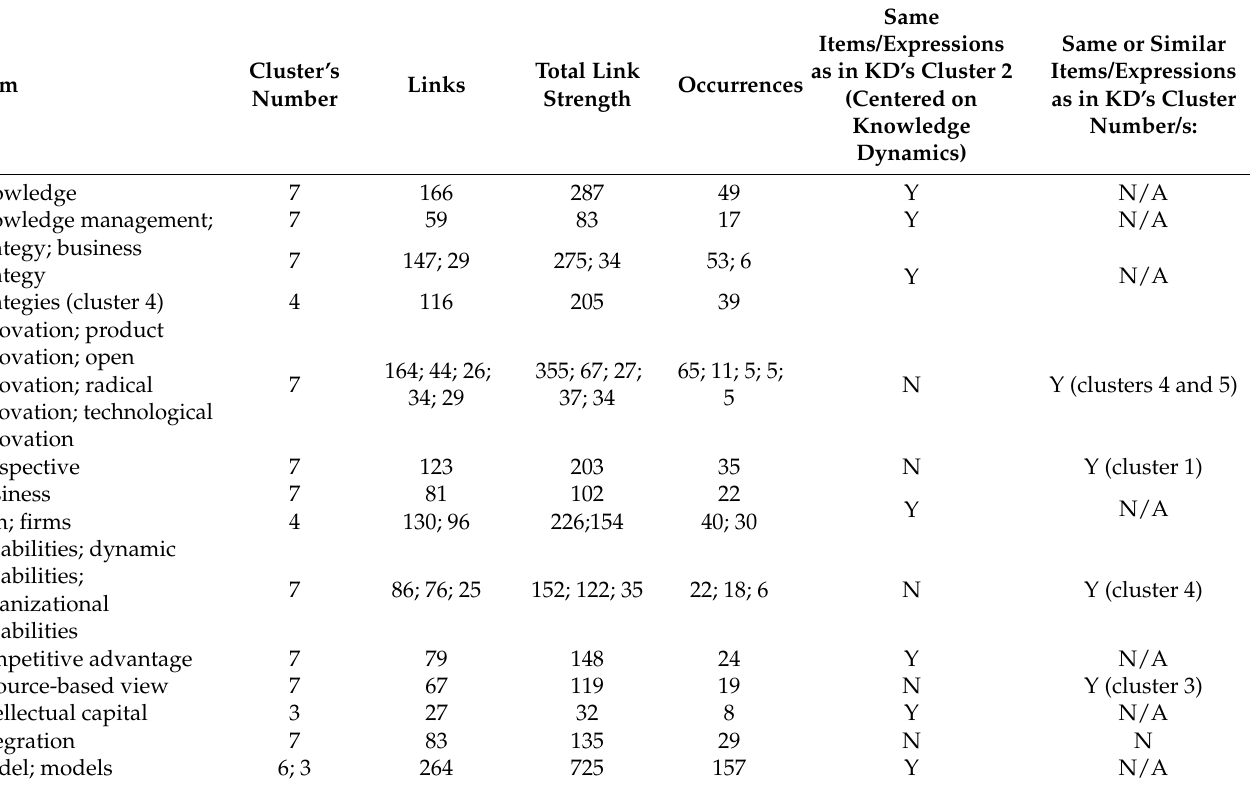
Table 7. MD: Cluster 7 (Knowledge): most relevant ten expressions by VOSviewer—embedded